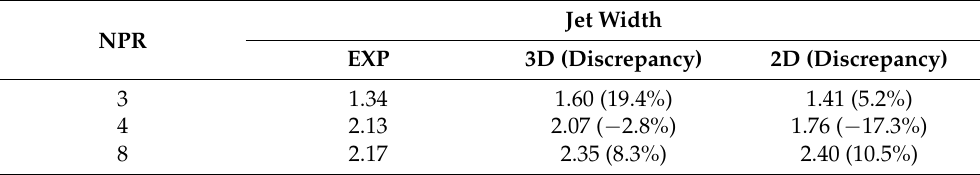
Table 4. Jet width at 1 H t location from the exit of the ramp section.